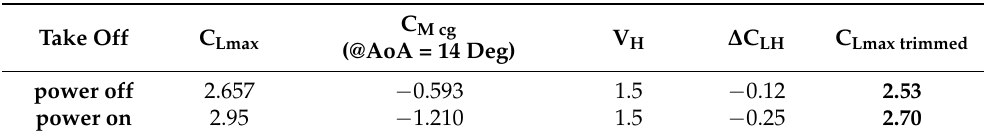
Table 16. Numerical results for take-off, trimmed maximum lift coefficient, moment coefficient calculated w.r.t. CG pos. (31% mac), power-on conditions: J TIP = 0.78, rpm TIP = 1600, J DEP = 0.89, rpm DEP = 2000. M = 0.15, Re = 5.7 × 10 6 .